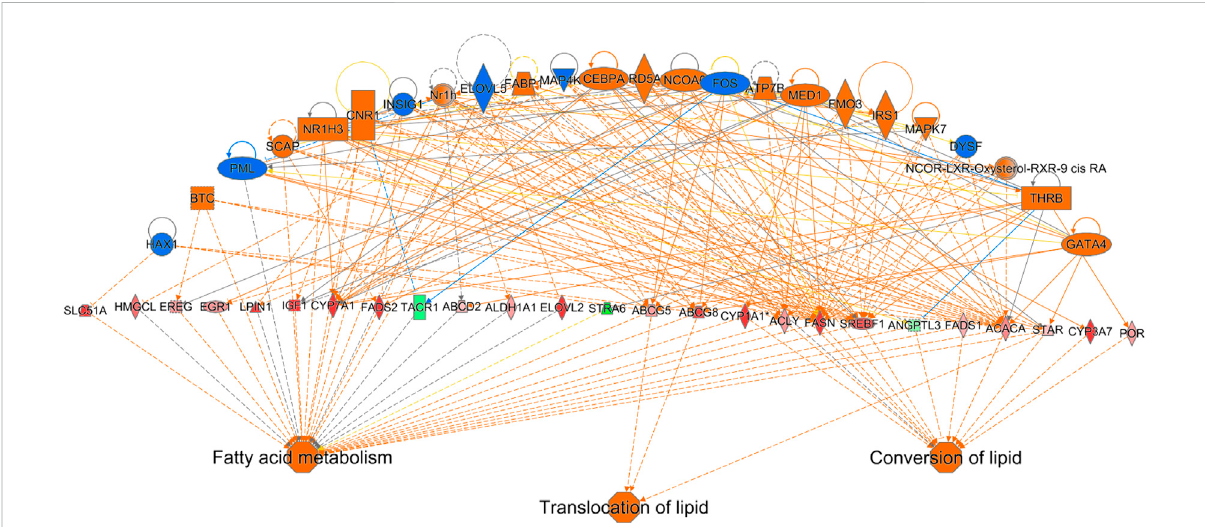
FIGURE 7 Network mapping of differentially expressed genes associated with fatty acid metabolism and lipid transport between DLY chicks and E18embryos.Networkmappingofdifferentiallyexpressedgenes(fold-change ≥ 5;FDR p -value ≤ 0.05)associatedwithfattyacidmetabolismandlipid transportbetweenDLYchicksandE18embryos.Geneexpressionpatternssuggestthebiggesttranscriptomedifferencesbetweenthesetwogroups are involve genes associated with lipid transport and function. Red molecules were signi fi cantly upregulated and green molecules signi fi cantly downregulated in DLY chicks. Orange indicates predicted activation and blue indicates predicted